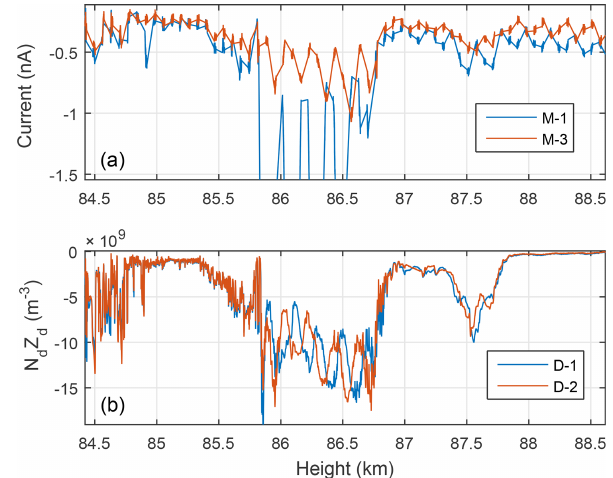
Figure 8. Comparison of MUDD-1 and MUDD-3 currents (a) and DUSTY-1 and DUSTY-2 charge number densities (b) . Both probe pairs display the same heavily spin-modulated feature at ∼ 86km, suggesting the presence of very small dust